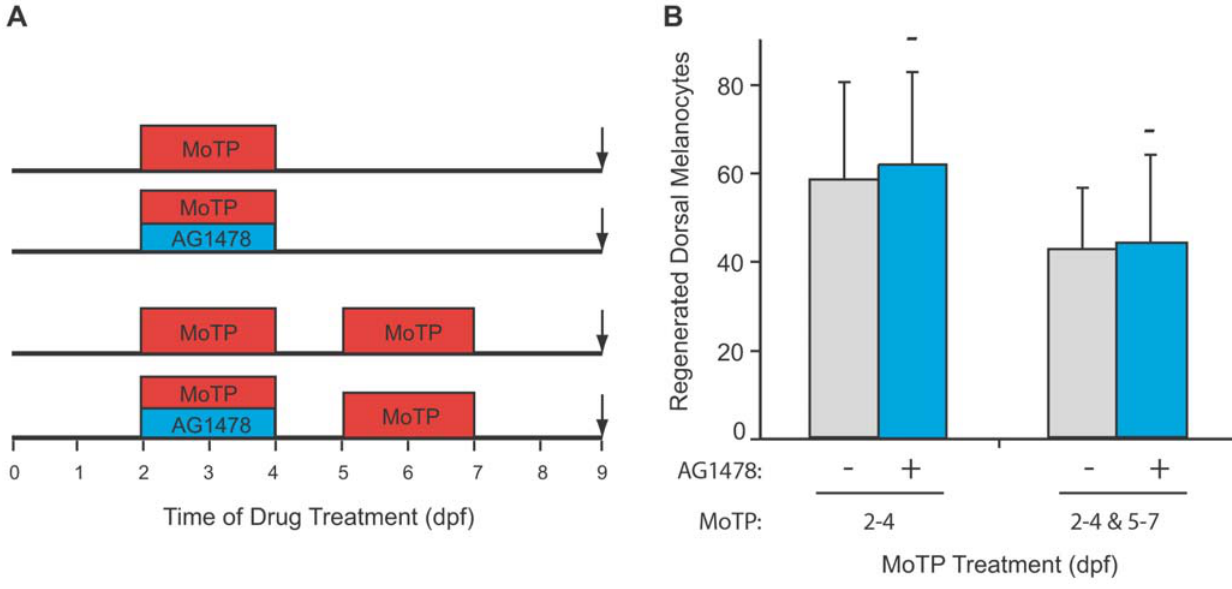
Figure 4. ErbB signaling is not required for stem cell self-renewal. (A) Cartoon of drug treatment timeline for single and double regeneration assays. (B) Quantitation of average regenerated dorsal melanocytes for each treatment in (A). Error bars represent standard deviation, - P . 0.05 (Student’s t-test, N=10 for single regeneration, . 5 for double regeneration). As previously shown (see Figure 2), when larvae are treated with AG1478 after 2 dpf, they regenerate normally following a single round of MoTP treatment. When animals are treated with two rounds of MoTP (from 2–4 dpf and from 5–7 dpf) they regenerate slightly less melanocytes than a single round by 9 dpf. To test whether AG1478 treatment would block stem cell self-renewal, we treated animals with MoTP and AG1478 from 2–4 dpf, and then with a second round of MoTP from 5–7 dpf. These animals regenerated melanocytes similar to non-AG1478 treated larvae for double regeneration (P=0.9).